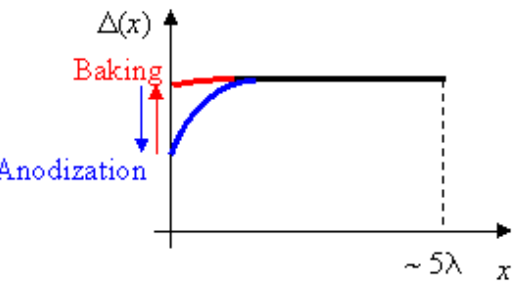
FIG. 17. (Color) Schematic representation of the space depen- dence of the energy gap and of the changes due to in situ baking and anodization. x represents the depth from the surface.